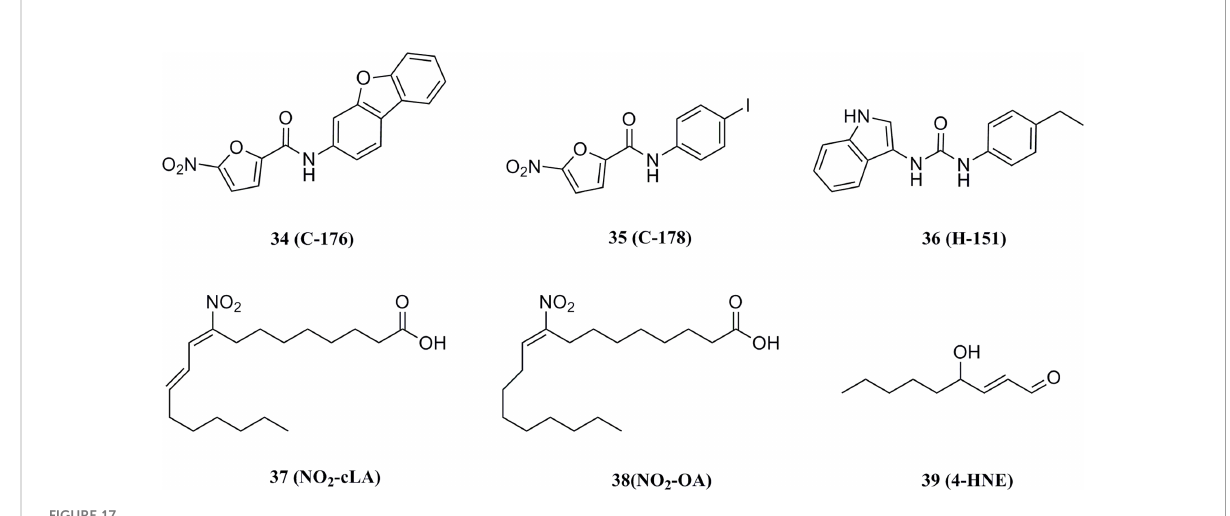
FIGURE 17 Structures of STING covalent binding